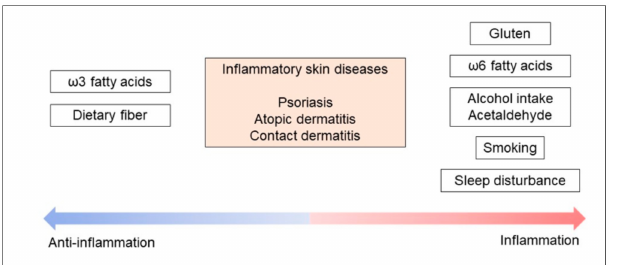
Figure 1. Inflammatory skin diseases are associated with daily lifestyle factors. This schema showed representative daily lifestyle factors related to the activation/regulation of inflammatory skin